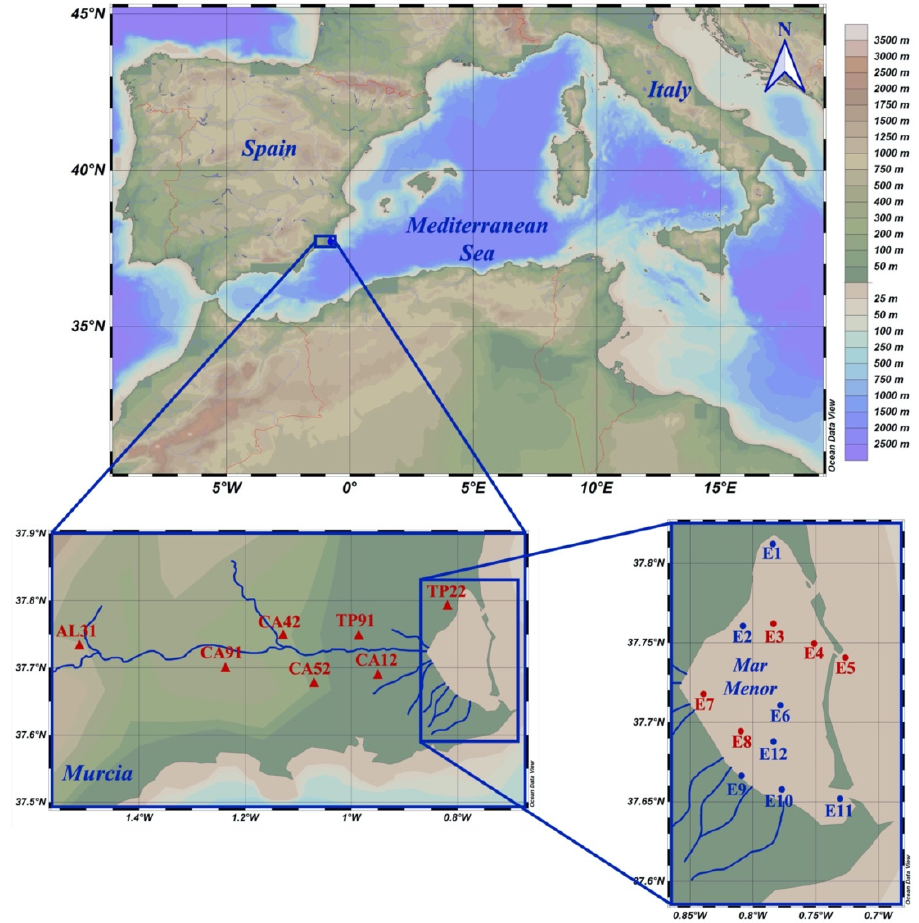
Figure 1. Location of the Mar Menor rainfall data stations (AL31: Lebor, Totana; CA12: La Palma, Cartagena; CA42: Balsapintada, Fuente Alamo; CA52: La Aljorra, Cartagena; CA91: Campillo Abajo, Fuente Alamo; TP22: Santiago de la Ribera, San Javier; TP91: Torre Pacheco, Torre Pacheco) and sampling stations within the lagoon territory. Sampling stations colored in red are the ones used for parameter analysis, based on their location (E3, E4, E5, E7, E8).